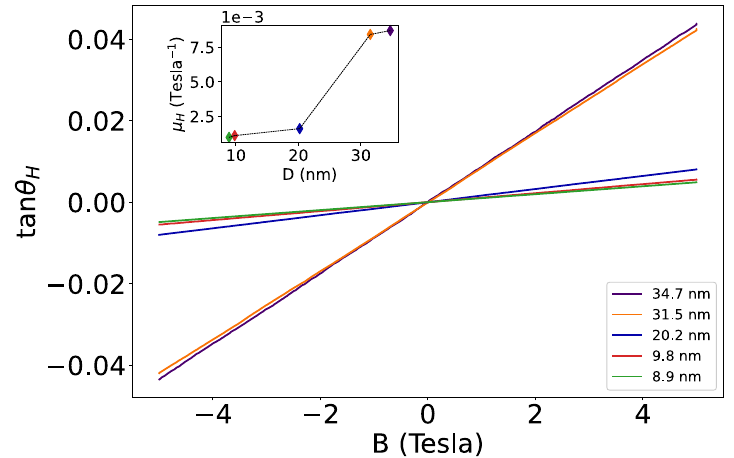
Figure 5. The Hall tangent measured on different samples at 5 K, plotted as a function of magnetic field strength B . In the inset is plotted the Hall mobility measured on different samples at 5 K, as a function of the mean grain